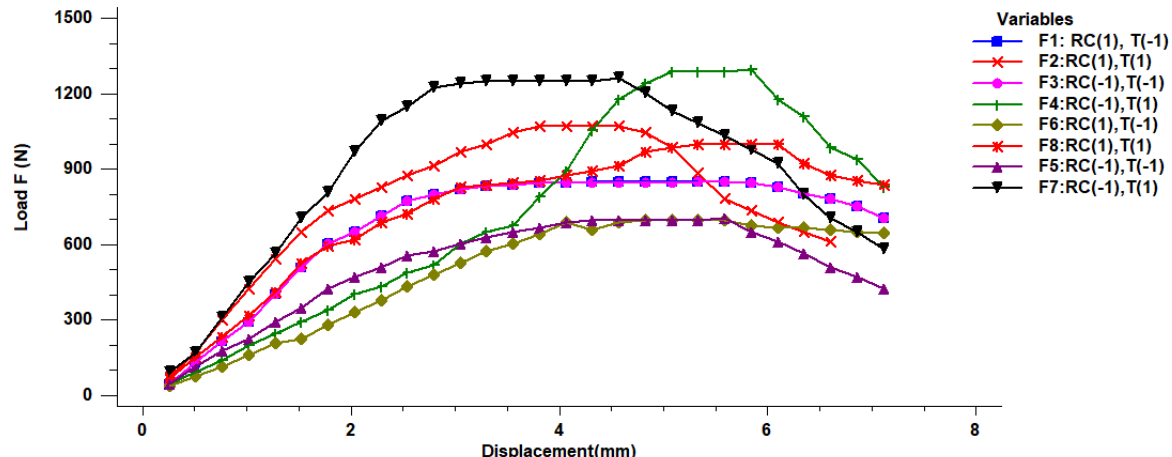
Figure 3 - Load and displacement relationship of particle